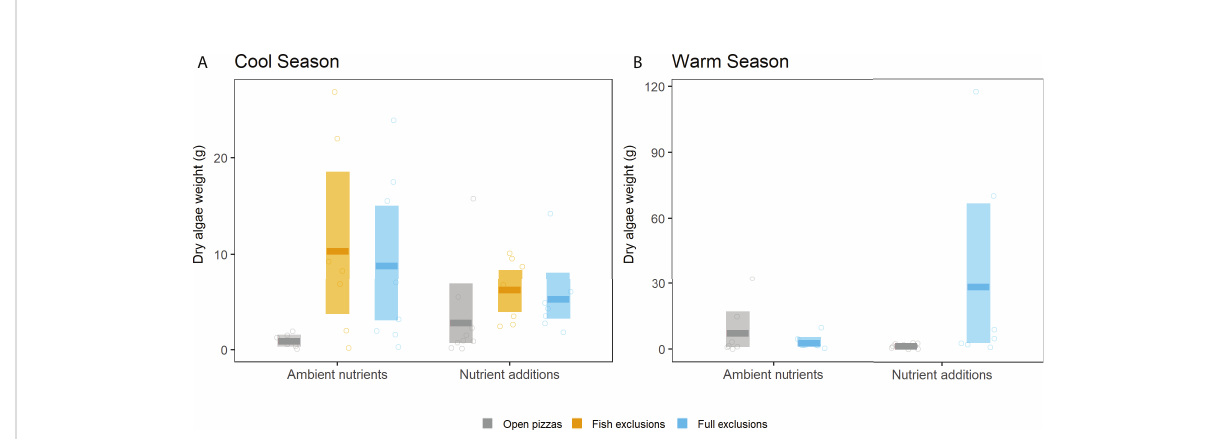
FIGURE 4 Herbivore treatment effects on fi nal macroalgal biomass (AFDW of all algal taxa, which was largely Ulva ) in the 2019 cool season (A) and the 2020 warm season (B) experiments. Bars represent bootstrap estimated means (darker, thick horizontal lines) and modelled 95% con fi dence intervals (entire shaded bar). Circles are the individual data raw points (n = 8). Note different scales in